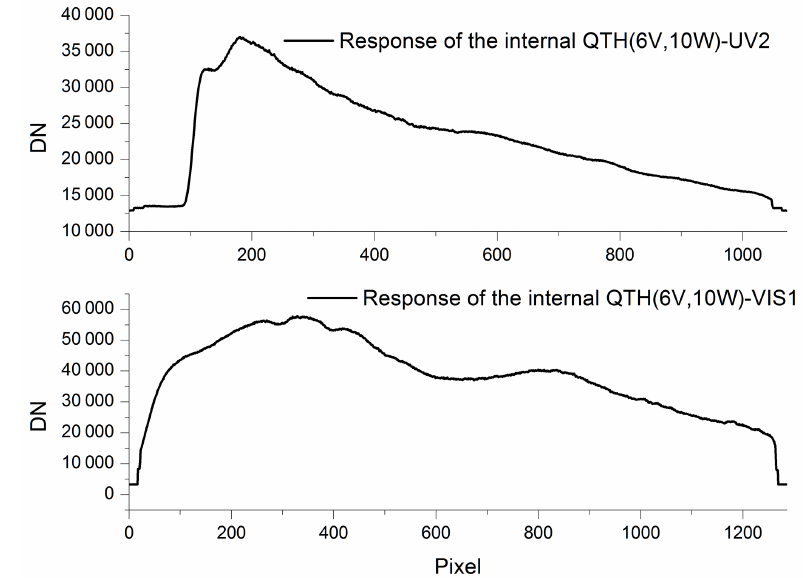
Figure 12. EMI on-ground response to the quartz tungsten halogen WLS.